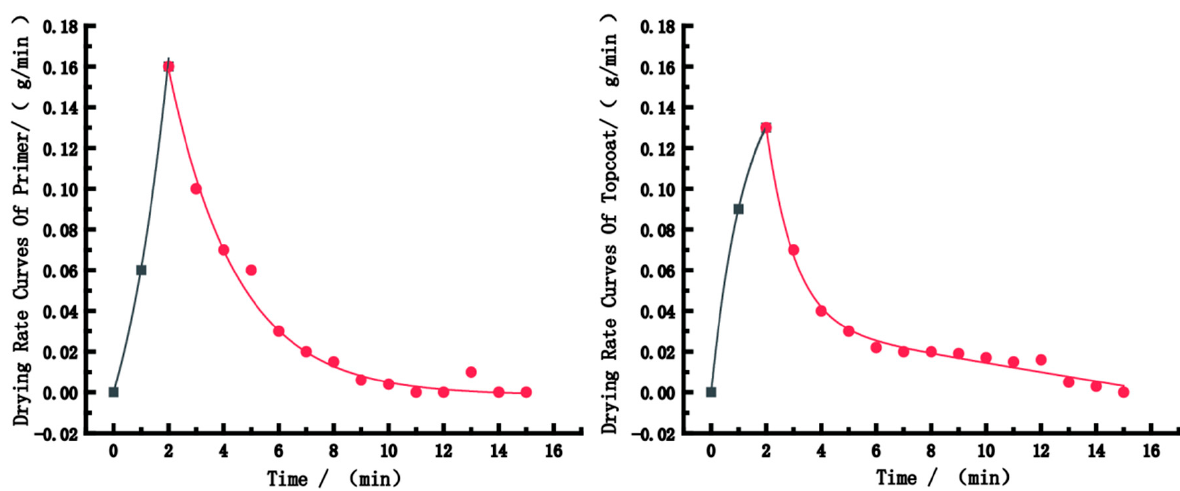
Figure 8. The drying rate curves of the paint films.